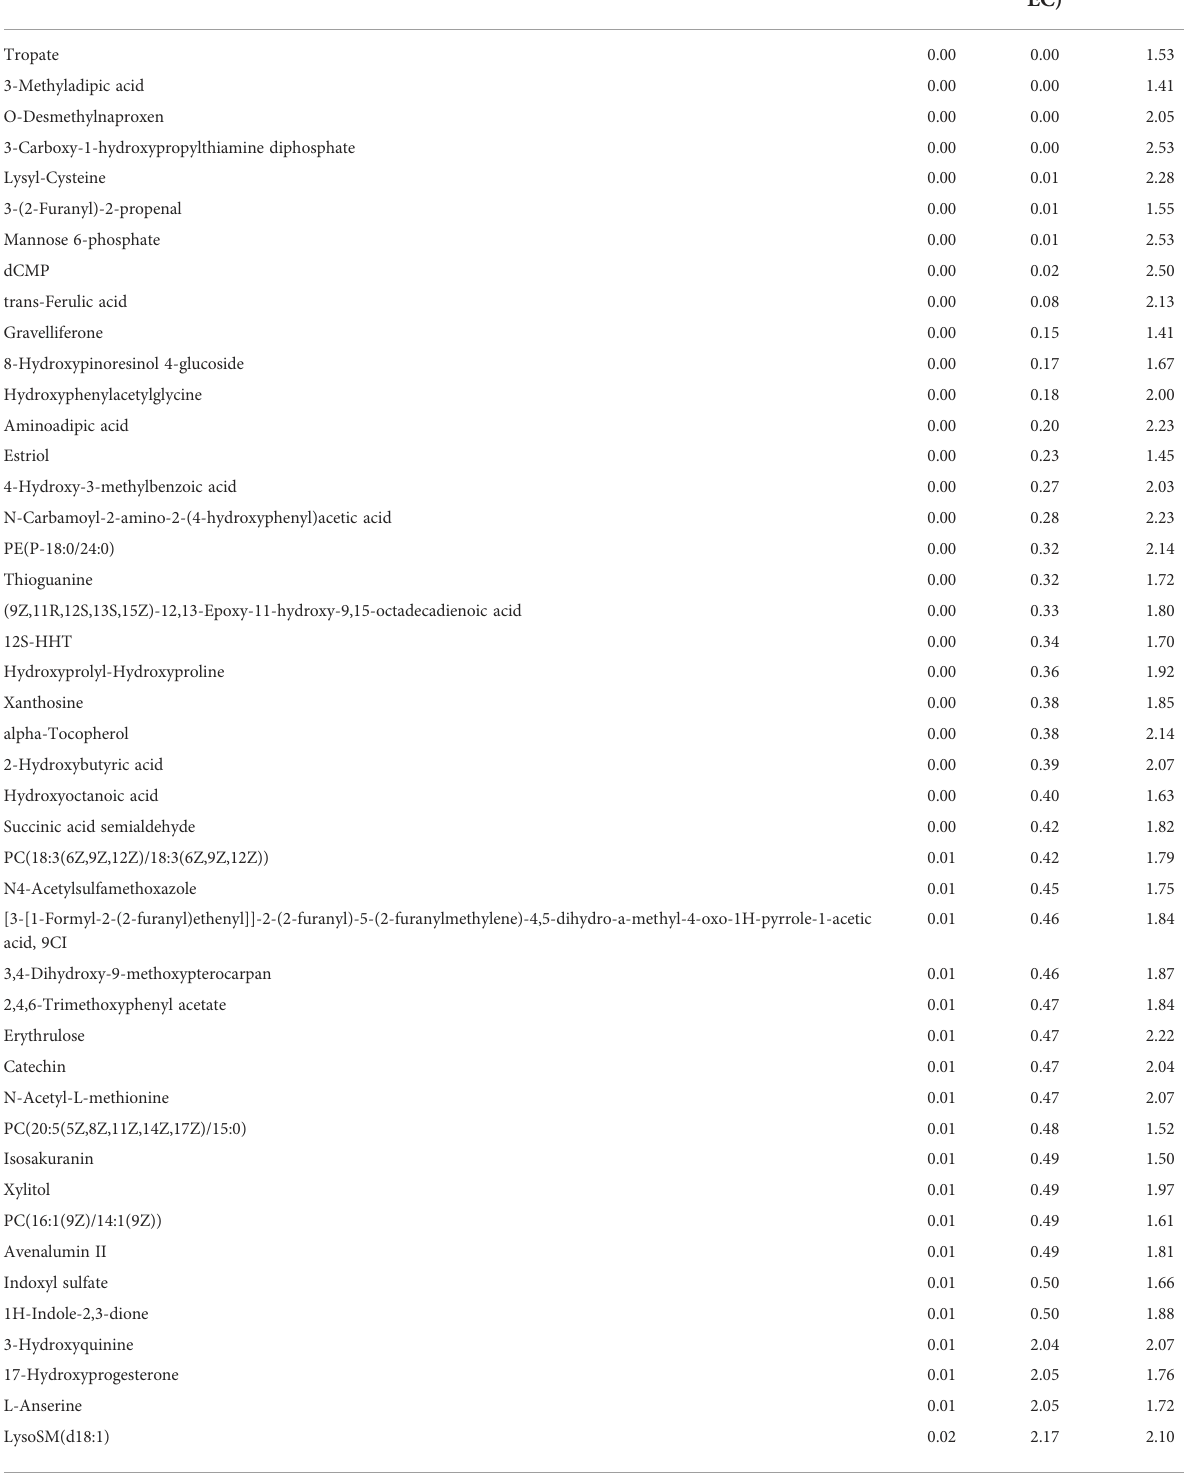
TABLE 2 41 upregulated and 25 downregulated metabolites in normal control (NC)vs. ethanol model (EC)